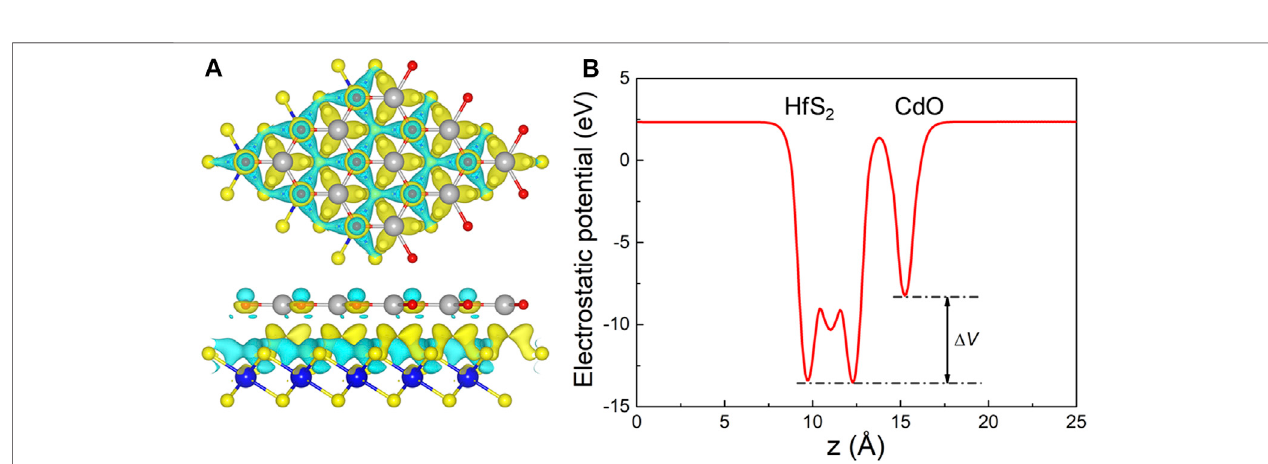
FIGURE 4 | (A) The charge density difference and (B) potential drop at the interface of the CdO/HfS 2 vdW heterostructure; the yellow and cyan regions mean the gaining and the loss of the electrons, respectively; the isosurface level is used as 10 − 4 | e |.